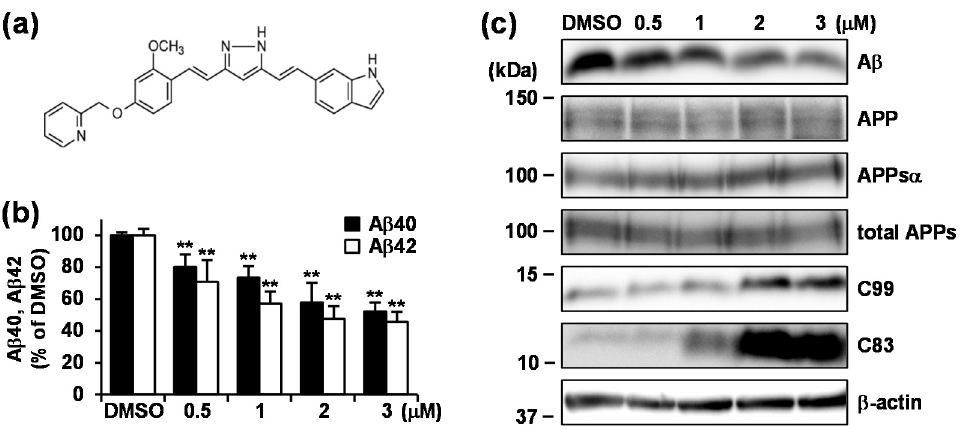
Figure 2. GT863 treatment for 48 h reduced secreted A β 40 and A β 42, and increased C99 and C83 levels in CHO-APP cells. ( a ) Chemical structural of GT863. ( b, c ) CHO-APP cells were treated with 0.5–3 μ M GT863 for 48 h. ( b ) Secreted A β 40 or A β 42 in conditioned media was measured by